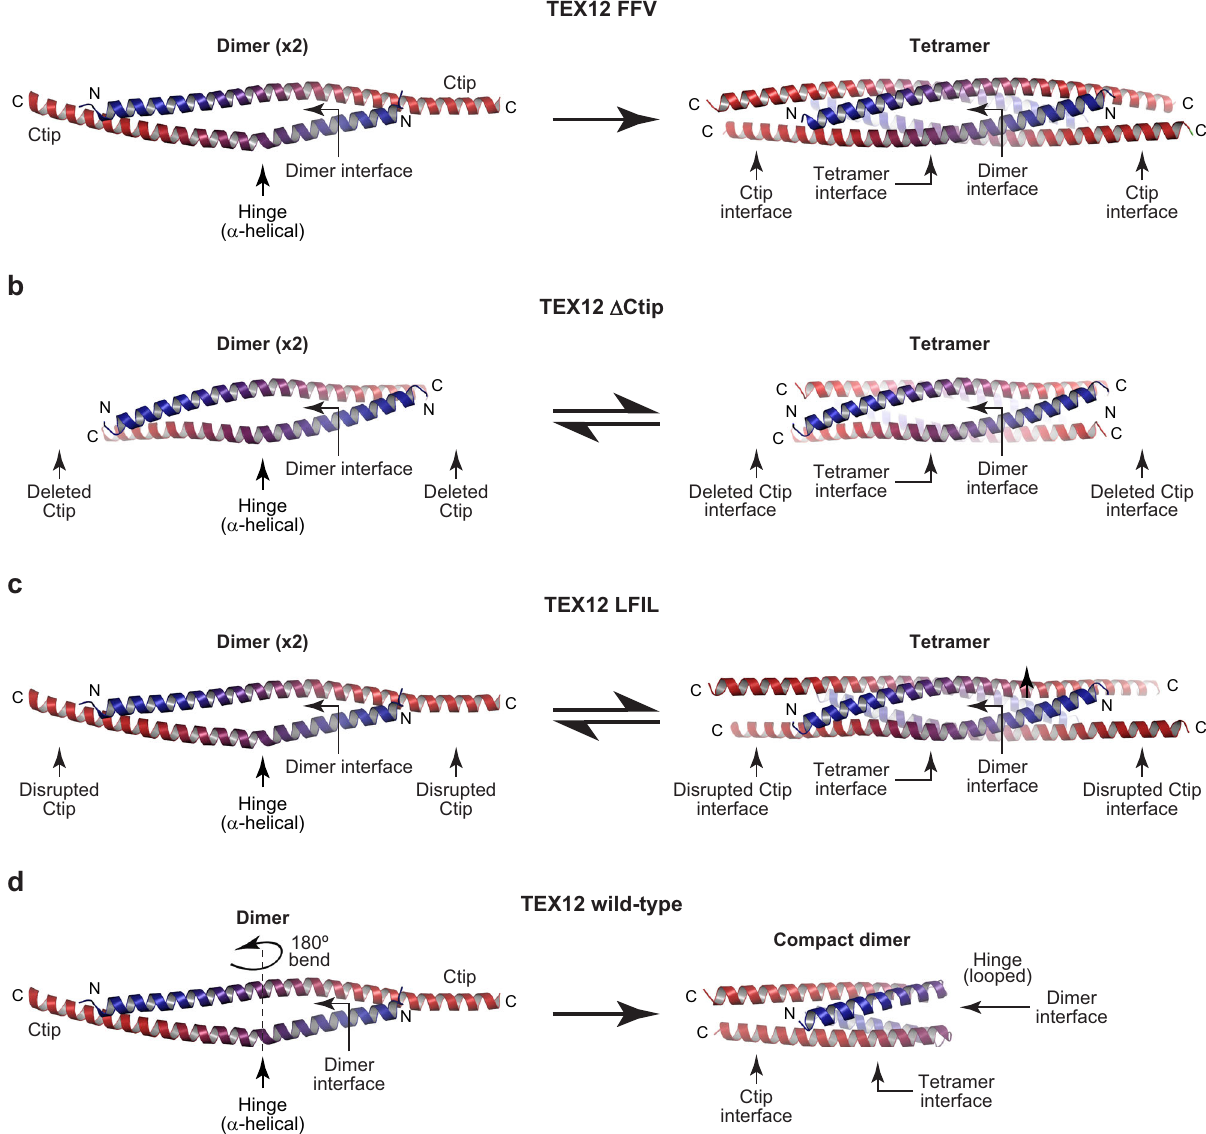
Fig. 8 Model for the oligomeric state and conformation of TEX12 wild-type and Ctip mutants. a – d The oligomeric state and conformation of TEX12 wild- type and Ctip mutants in solution can be explained by their conserved dimer, tetramer and Ctip interfaces. a TEX12 FFV dimers associate into tetramers that are stabilised by Ctip interfaces at either end of the molecule, accounting for the sole presence of extended tetramers in solution. b TEX12 Δ Ctip and c TEX12 LFIL dimers associate into tetramers that remain unstable owing to their deleted and disrupted Ctip interfaces, accounting for the concentration- dependent dissociation of tetramers into mixtures of tetramers and dimers in solution. d Wild-type TEX12 dimers fold back on themselves by adopting helix – loop – helix structures in which the hinge transitions from α -helical to looped conformations. In this structure, the dimer and tetramer interfaces are formed by only two chains, and are stabilised by a Ctip interface supported by intact F102 and V116 amino-acids, accounting for the sole presence of compact dimers in